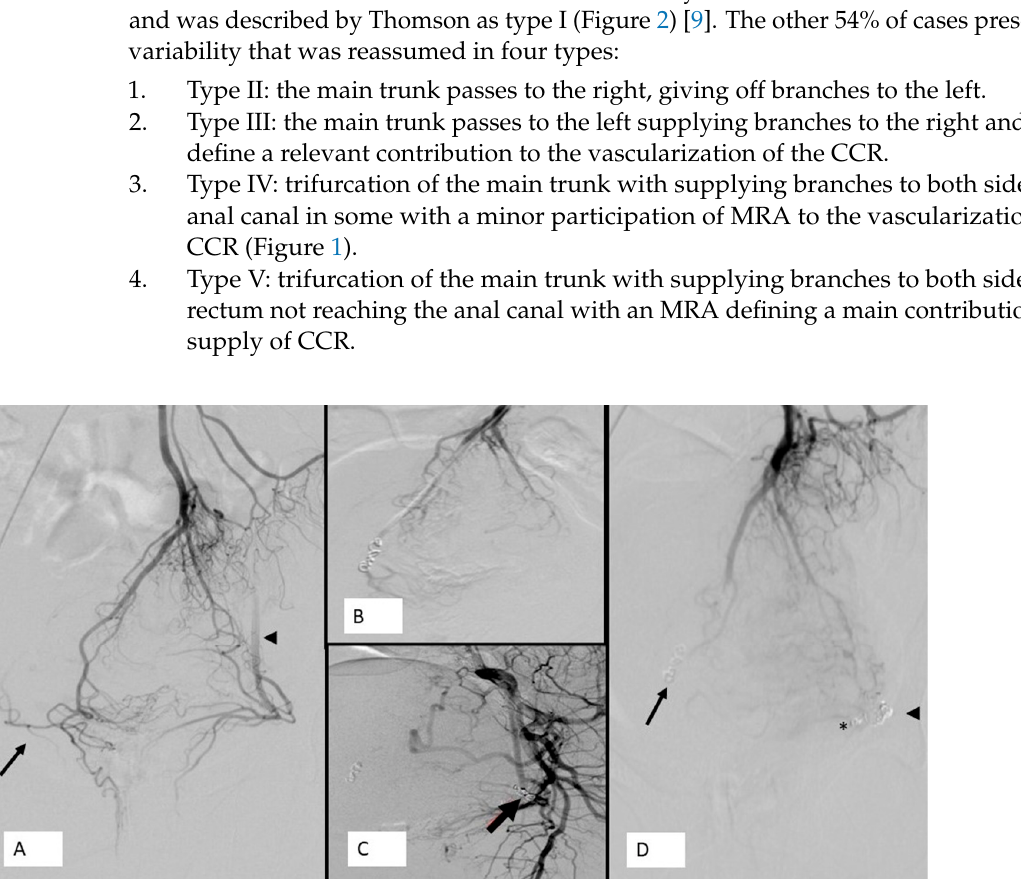
ported an origin of MRA from internal pudendal artery (IPA) and inferior gluteal artery (IGA) in 40% and 26%, respectively [19]. The knowledge of the anatomy of the MRA is fundamental for the understanding and management of patients treated by endovascular route. Thomson found in 10% of cases the type V anal vascularization that defined “inter- esting and previously undescribed vascular anomaly”: in this pattern, the MRA supply most of the anal canal vascularization usurping the function of the superior rectal artery. However, the anatomy studies available nowadays are obtained on the cadavers of healthy subjects not affected by hemorrhoidal pathology. In consideration of the promi- nent role of vascular abnormalities at the basis of hemorrhoidal pathogenesis (arterial hy- perflow) [16], it is likely that in subjects affected by hemorrhoids the vascular pattern is different from that reported in healthy subjects. In the results of a prospective clinical study on the efficacy and safety of superior rectal artery embolization of hemorrhoidal disease as a first-line invasive treatment, Tradi reported an incidence of the type V pattern of vascularization in 24% of hemorrhoid patients. The relevance of the fundamental role of MRA in the CCR perfusion is supported by the fact that in most of the studies available, despite a primary technical success of complete SRA occlusion below the pubic symphy- sis, the clinical relapses are often supported by an angiographic finding of prominent MRAs supplying the corpus cavernosum of the rectum [20–22]. Hence, the rationale for the use of particles during the embolization of the SRA so as to occlude the SRA-MRA connections and the hypothesis sustained by several authors to occlude the MRA when- ever visible from the angiographic examination of the SRA. 6. Embolization Agents Among several embolization agents available nowadays in interventional radiology practice, to our knowledge, until now, only two have been reported in the emborrhoid technique: coils and particles.